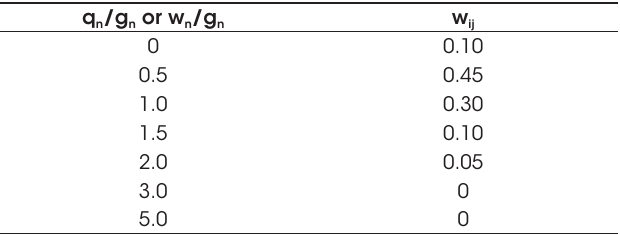
Weights w (adapted from Ellingwood et al [5])